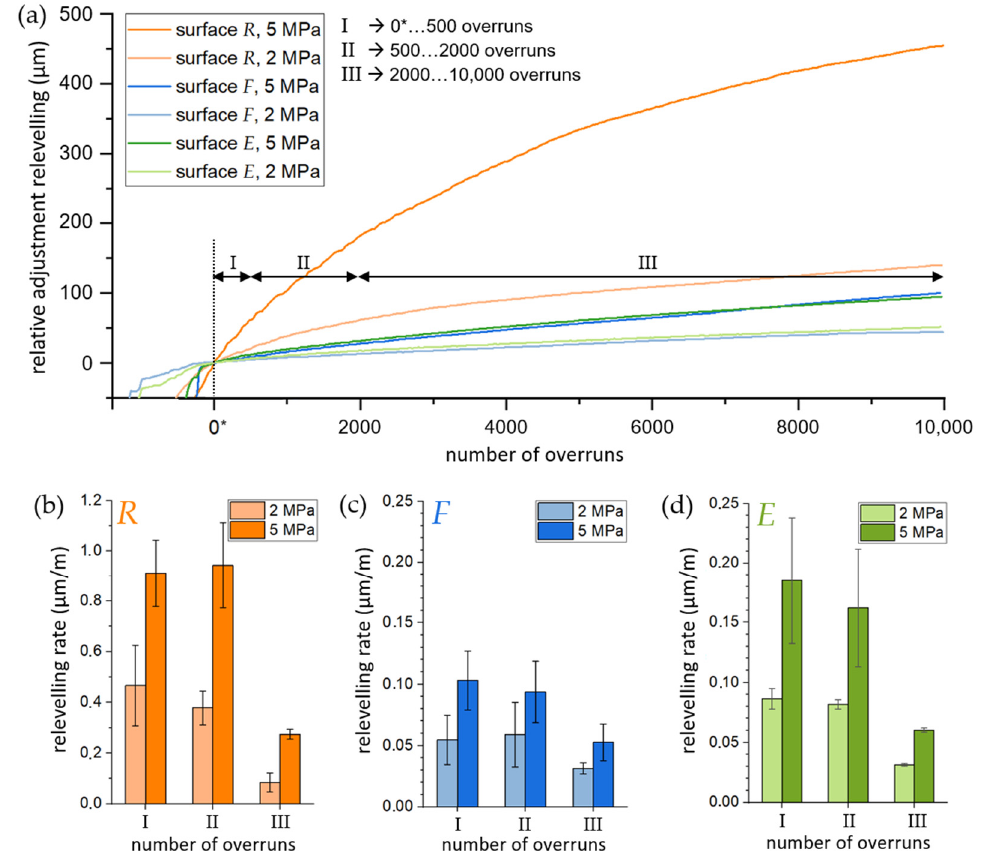
Figure 6. ( a ) Typical AR curves of the long tests (1500 m sliding distance) for each surface condition and preset pressure. AR rate ( b – d ) is determined after reaching constant test conditions (0* overruns). Note that scale of ( b ) differs from that of ( c , d ).